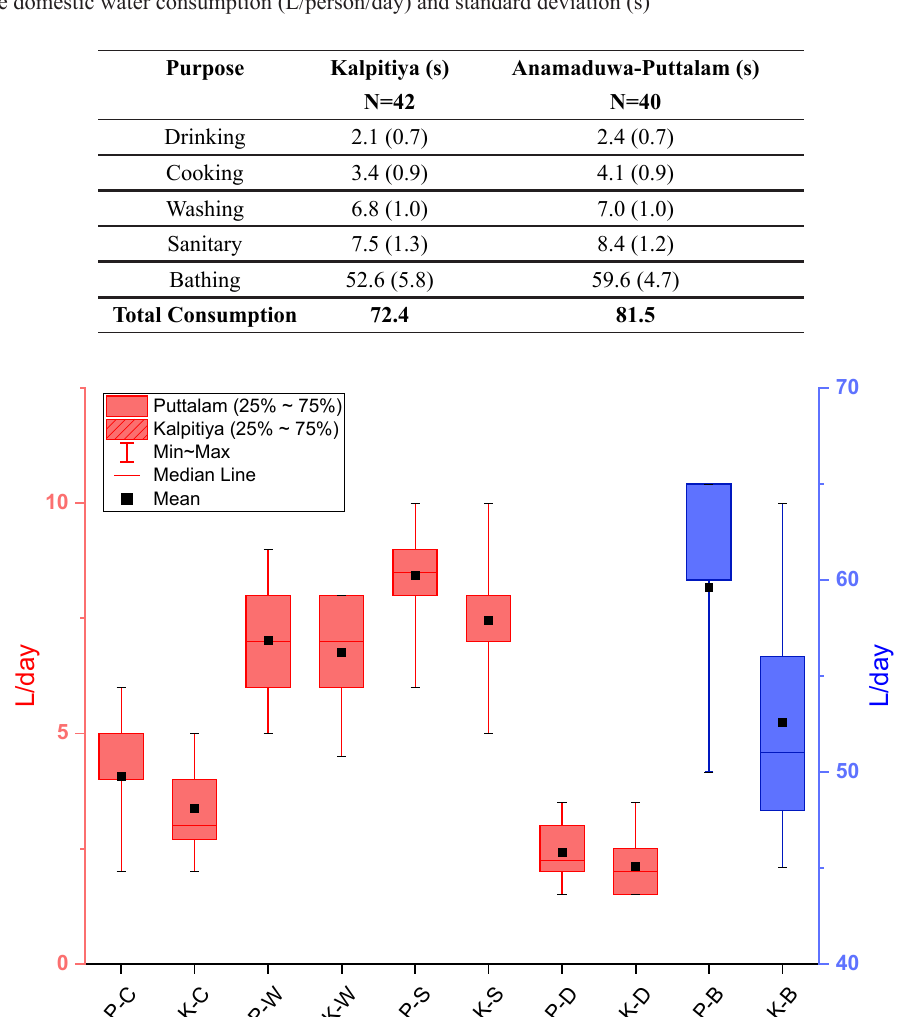
Figure 2: Box and Whisker plots of per capita domestic water consumption for Puttalam (P) and Kalpitiya (K) areas. C-Cooking; W-Washing; S-Sanitary; D-Drinking;